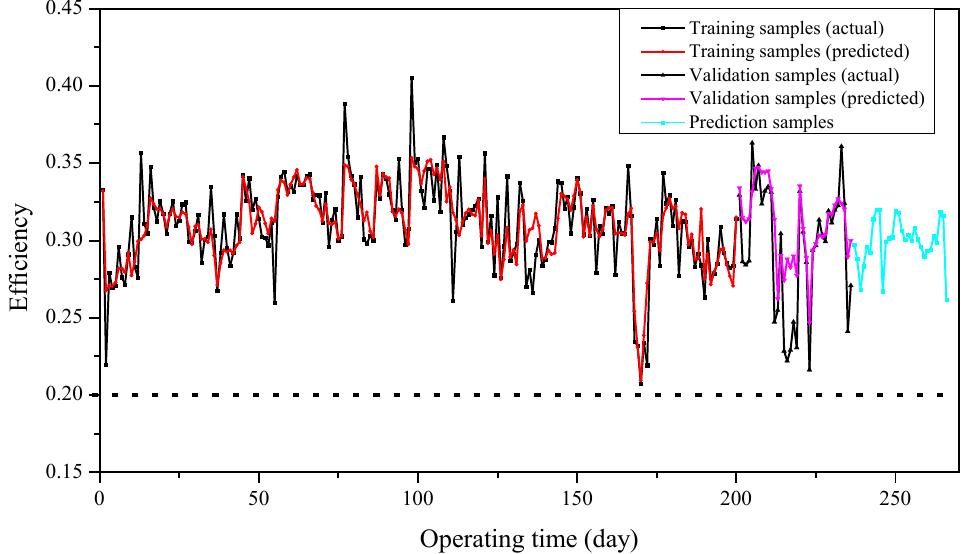
Figure 8. The prediction results of the SVM.